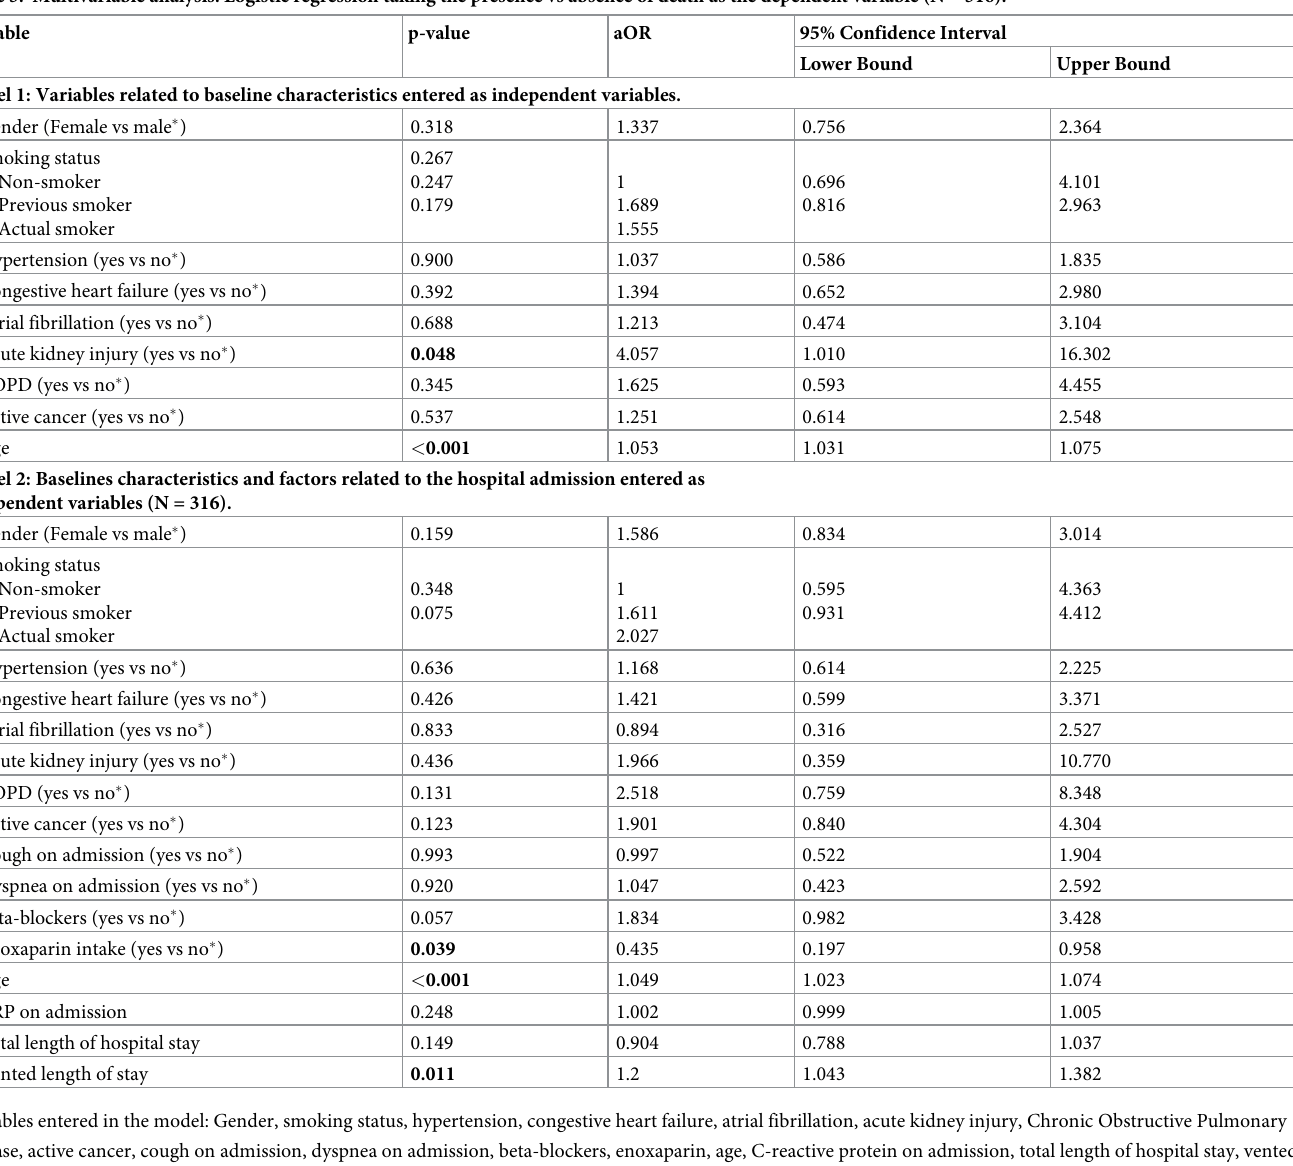
Table 3. Multivariable analysis: Logistic regression taking the presence vs absence of death as the dependent variable (N = 316). Variable p-value aOR 95% Confidence Interval Model 1: Variables related to baseline characteristics entered as independent variables.